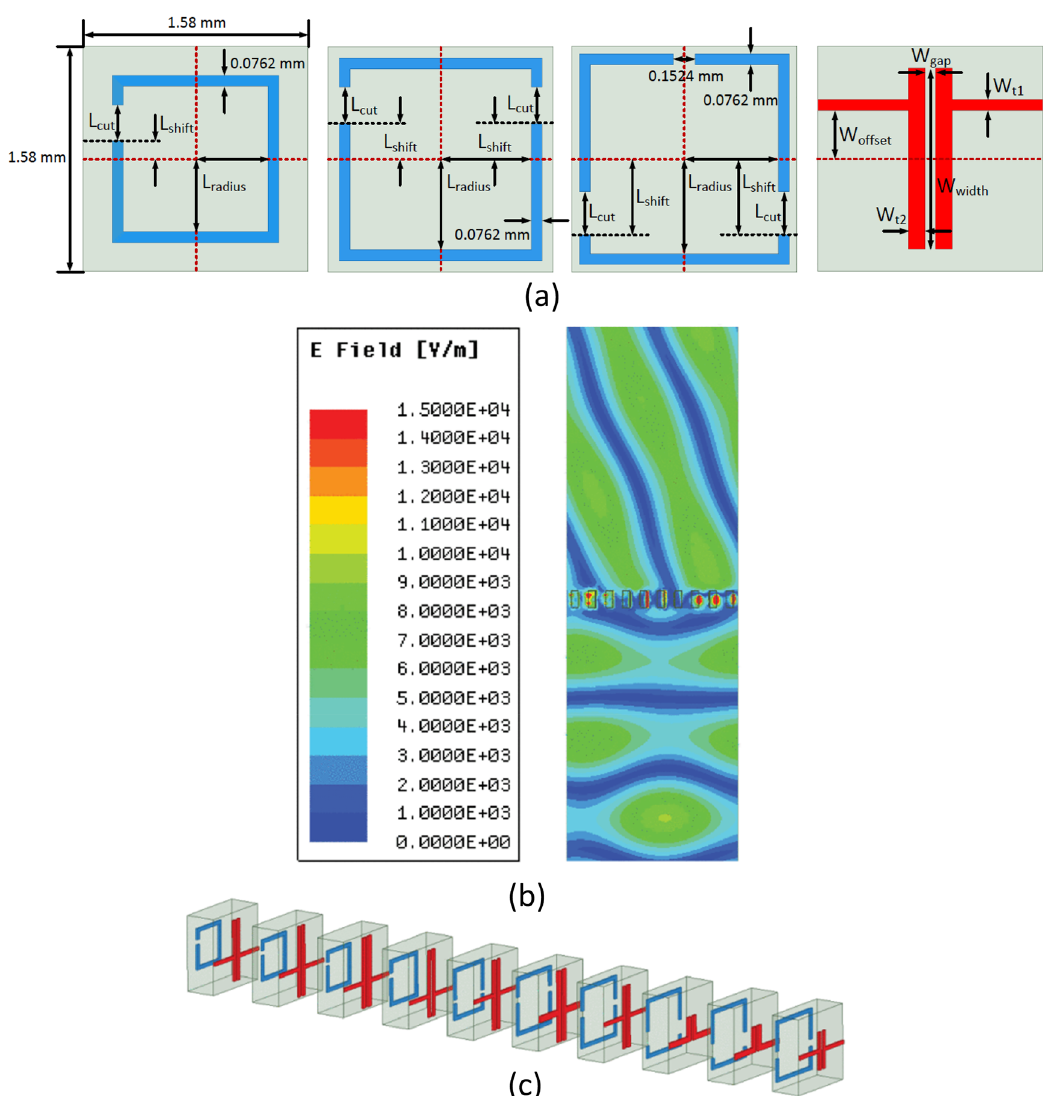
Figure 20: (Reprinted with permission from Ref. [24]). (a) Proposed omega-bianisotropic wire – loop geometries for (leftmost) single-cut loop, (second from left) double-cut loop, (third from left) triple-cut loop, (fourth from left) shifted wire. (b) TE refraction design full-wave simulation, electric fi eld distribution of one period via periodic simulation in HFSS at 20 GHz. (c) Physical period of the TE refraction